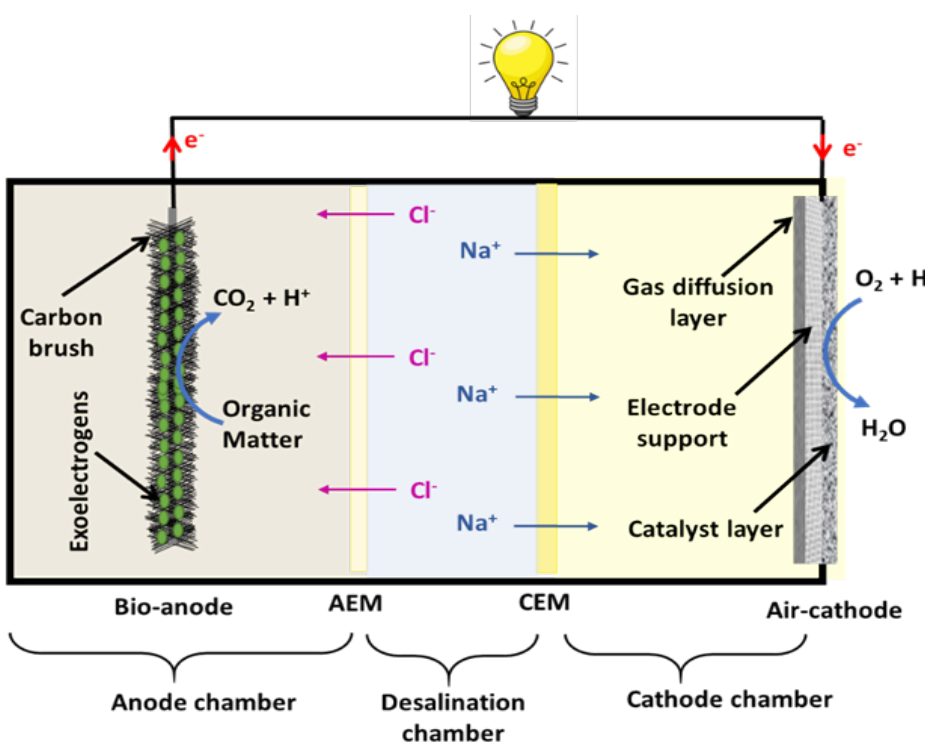
Figure 1. Schematic diagram of typical (MDC).